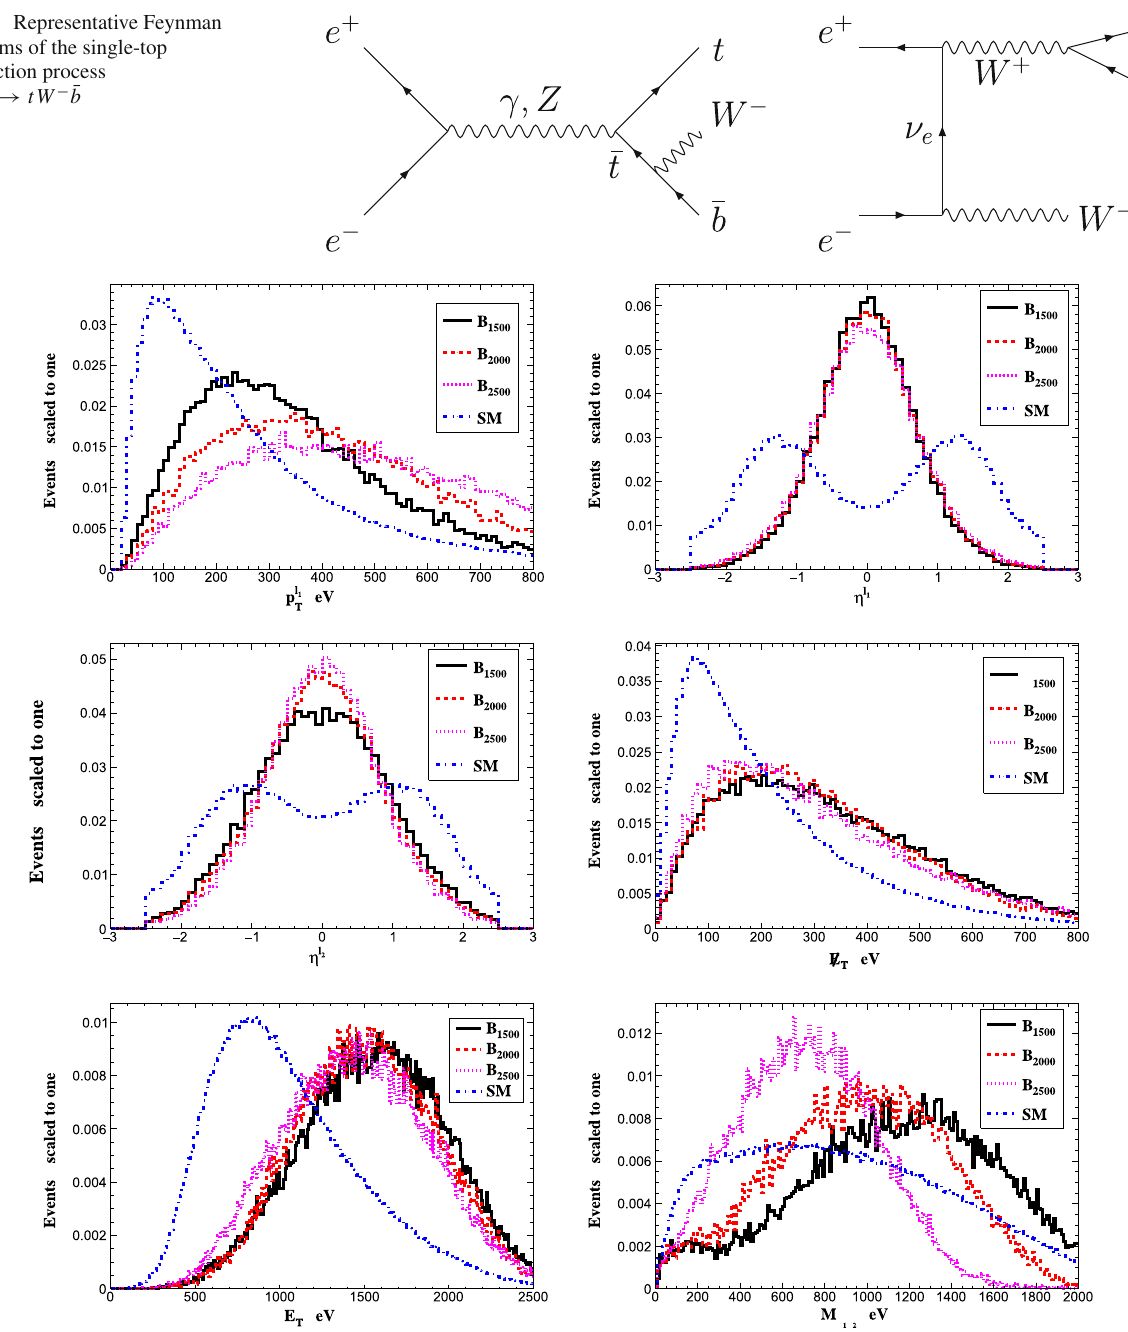
Fig. 4 Normalized distributions for the signals (with m B = 1500 , 2000, and 2500 GeV) and SM background at the CLIC